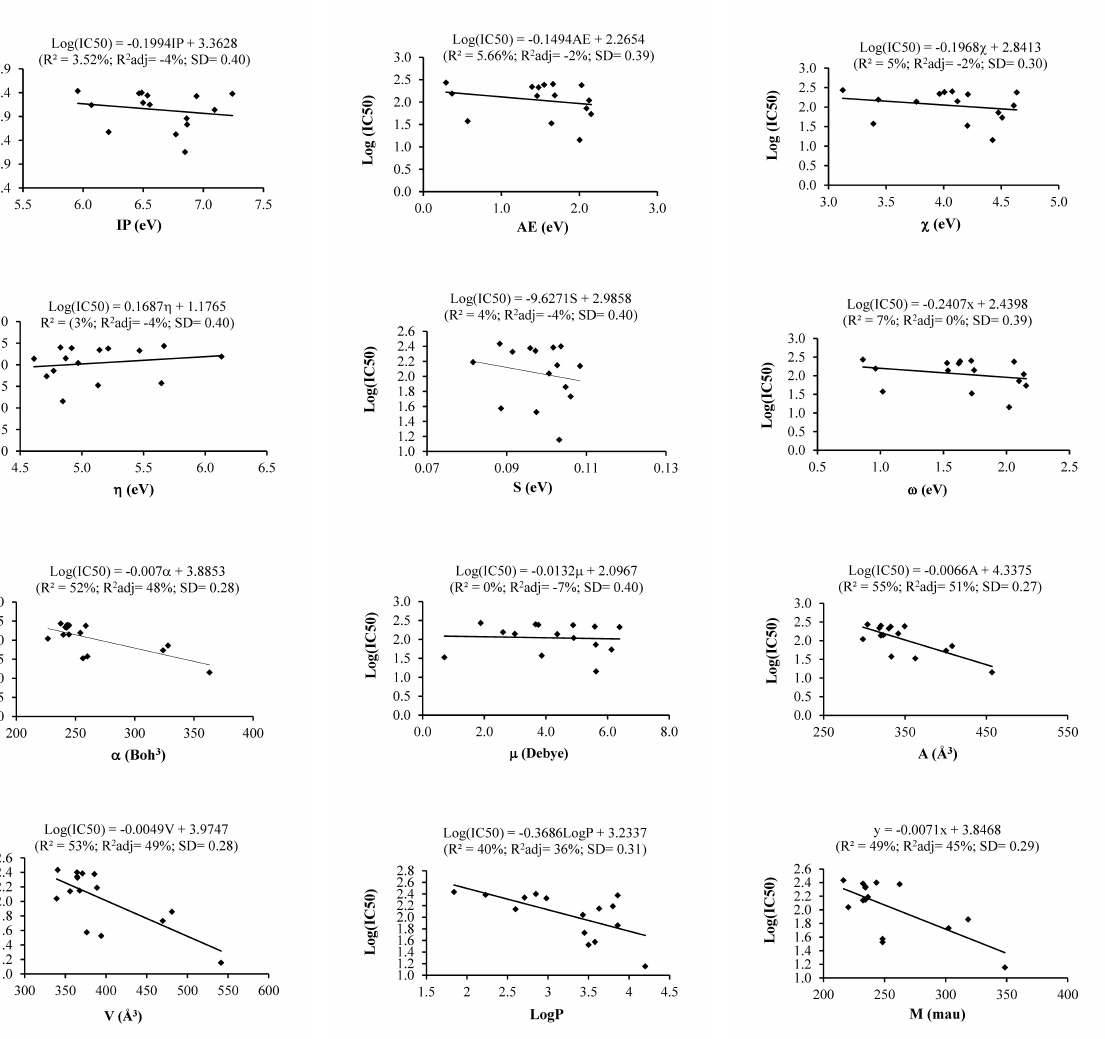
Figure 2. Simple linear regression correlation (SLR) curves between the cytotoxic activity on MCF-7 cells and each descriptor of isolated compounds from C. zedoaria